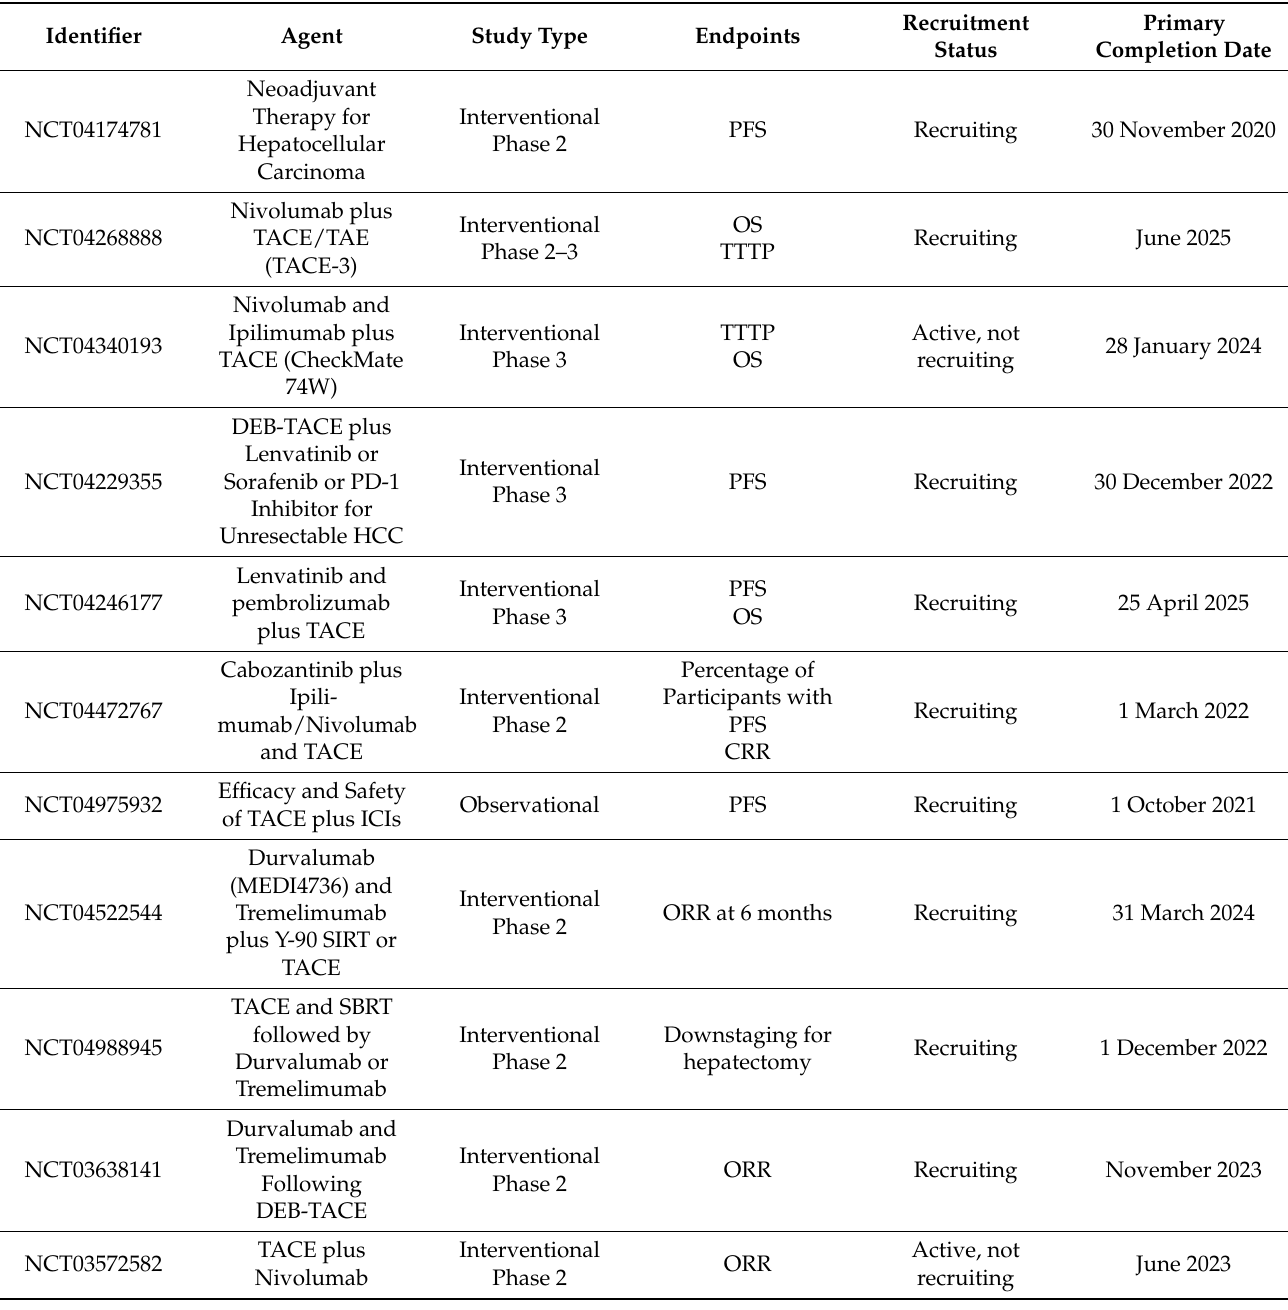
Table 4. Current and ongoing studies of combination treatment and immunotherapy for intermediate